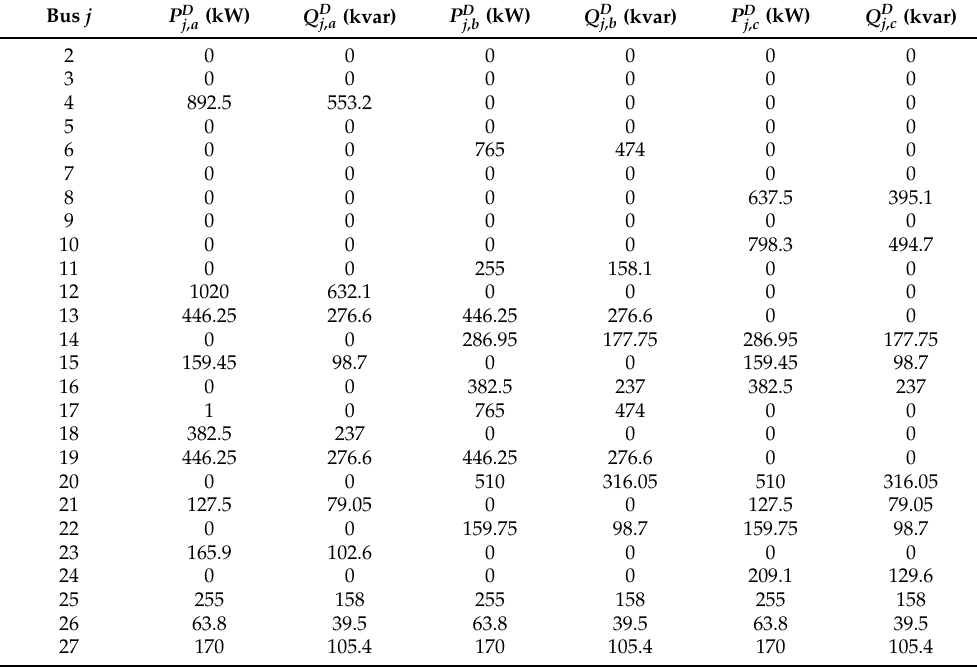
Table 7. Information corresponding to the 27-bus test system for the unbalanced